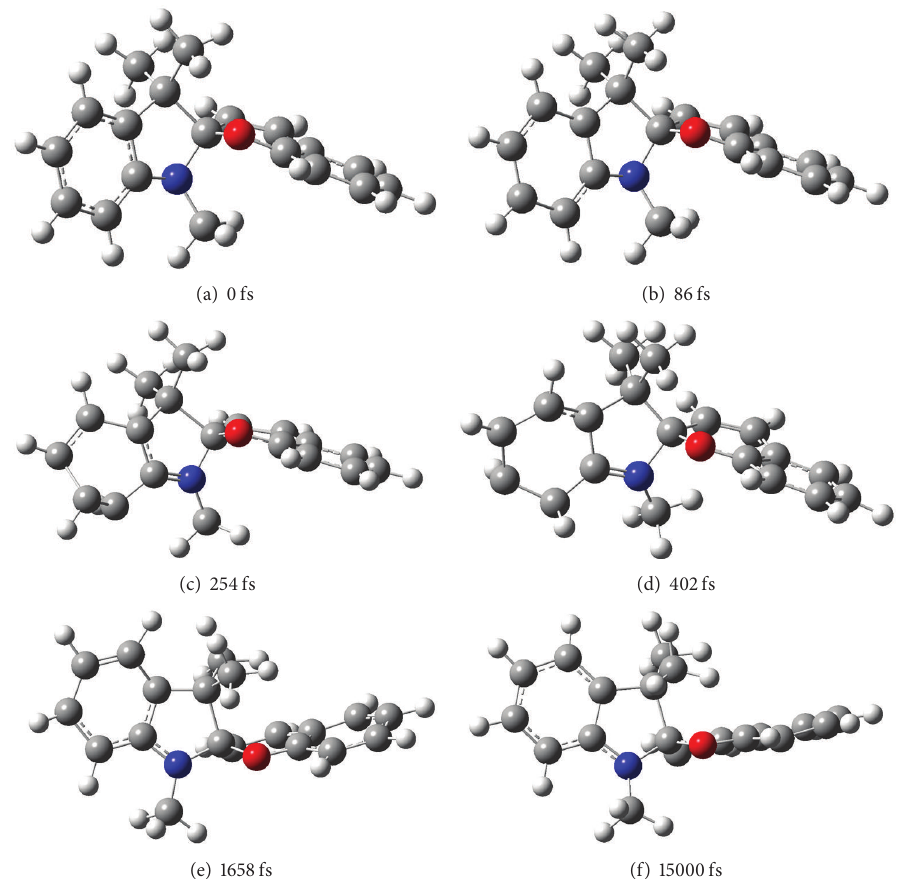
Figure 1: Snapshots taken at different times in a simulation of cis-SP in response to excitation by a 80 fs (FWHM) laser pulse with a fluence of 0.188 kJ/m 2 and photon energy of 4.054 eV, Atom C, H, N, and O are, respectively, denoted by dark grey, French grey, blue, and red; (a)–(f) are at 0 fs, 86 fs, 254 fs, 402 fs, 1658 fs, and 15000 fs, respectively.